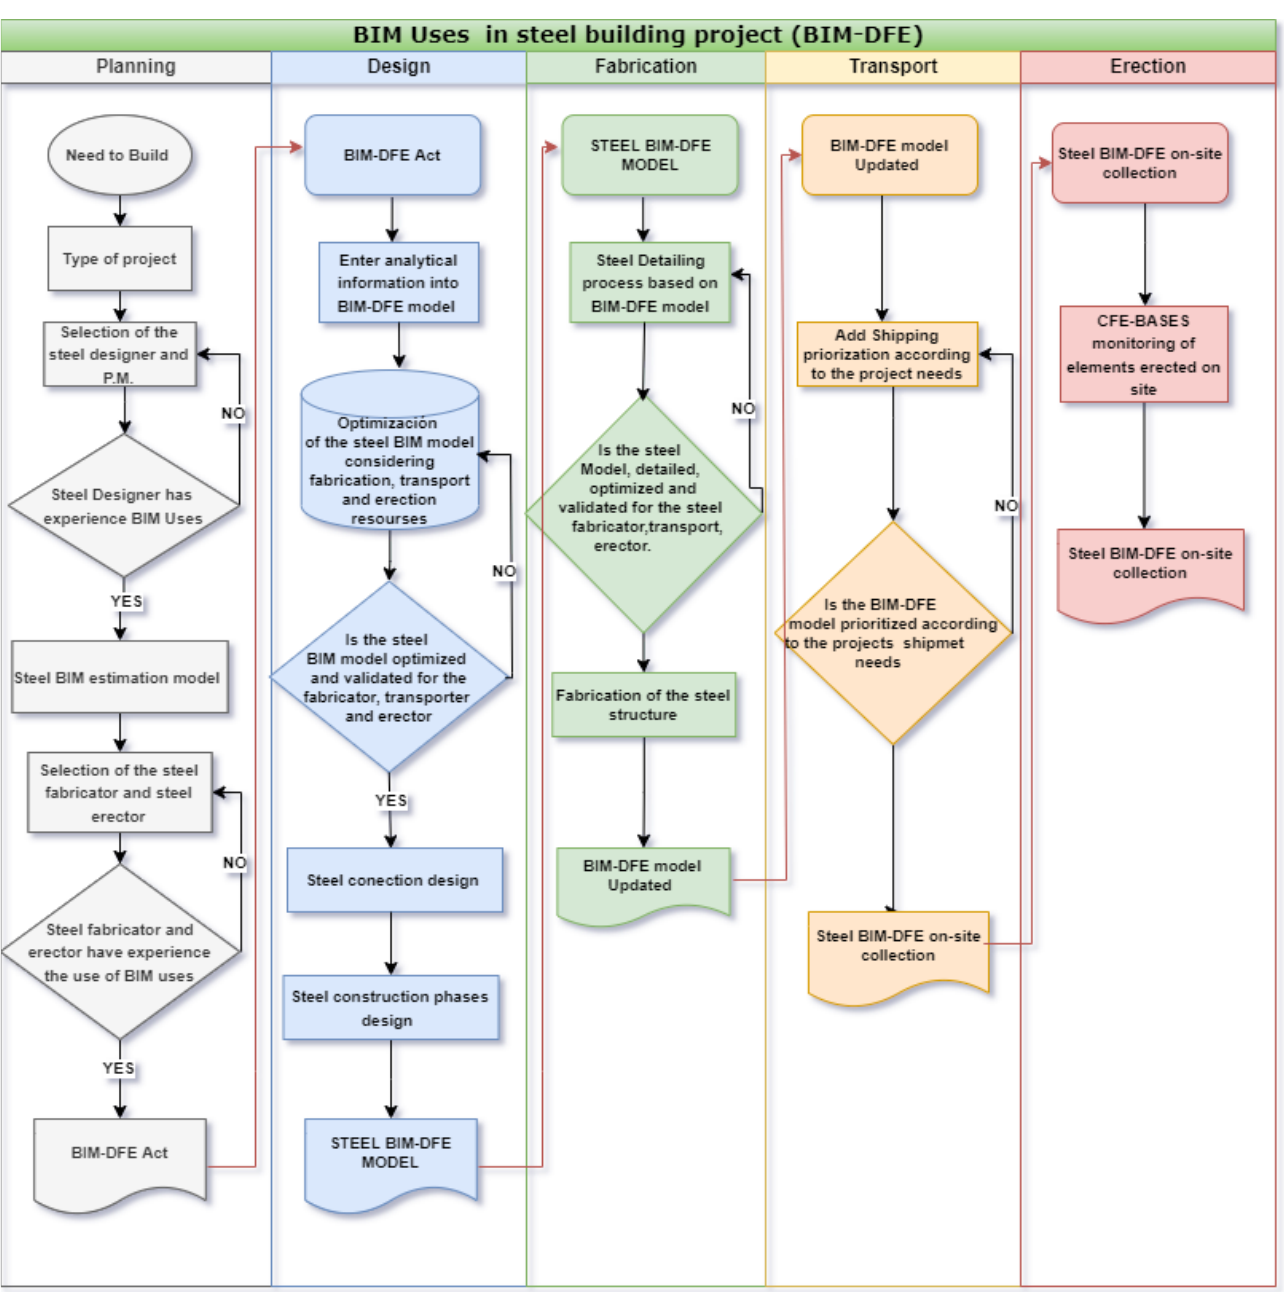
Figure 7. Final consensus of the BIM integration model in steel building projects after the Delphi survey based on expert